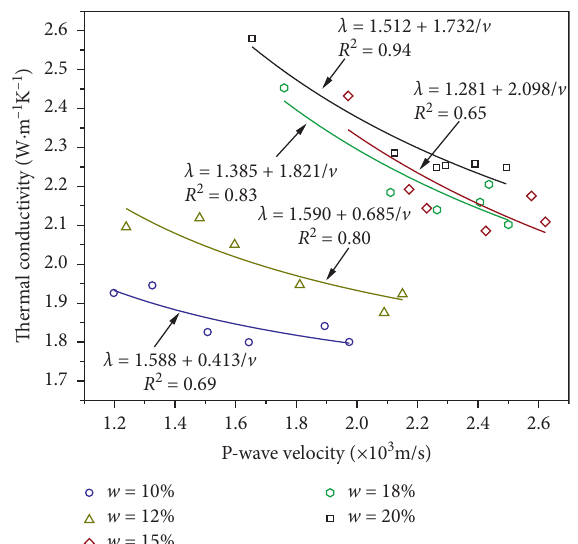
Figure 7: Relationship between thermal conductivity and P-wave velocity of frozen silty clay soil from − 4 ° C to − 20 ° C.